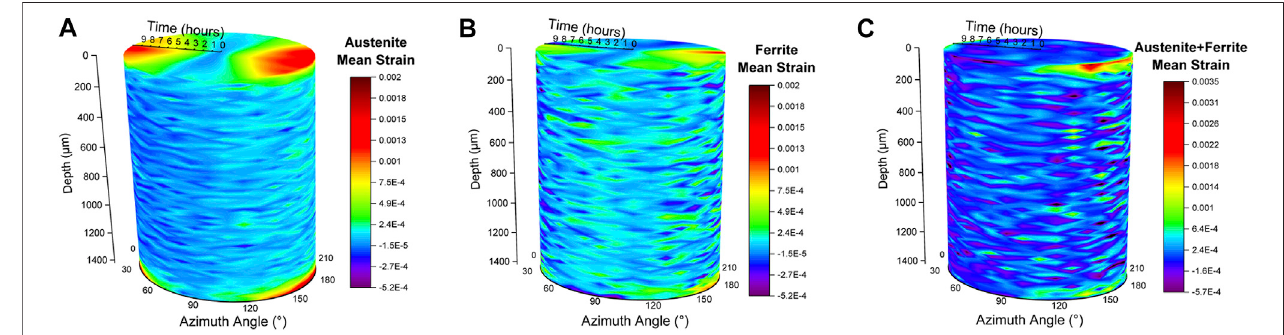
FIGURE6| 3-Dpolarstrainplotshowingthelatticestraindevelopmentasafunctionoftime(thecentreist (cid:1) 0)ofhydrogenchargingatdifferentdepth(thetopisthe surface,depth (cid:1) 0)regionsalongwiththeazimuthanglesin (A) theaustenitephase, (B) theferritephase,and (C) thesumofthestrainsintheferriteandaustenitephases.